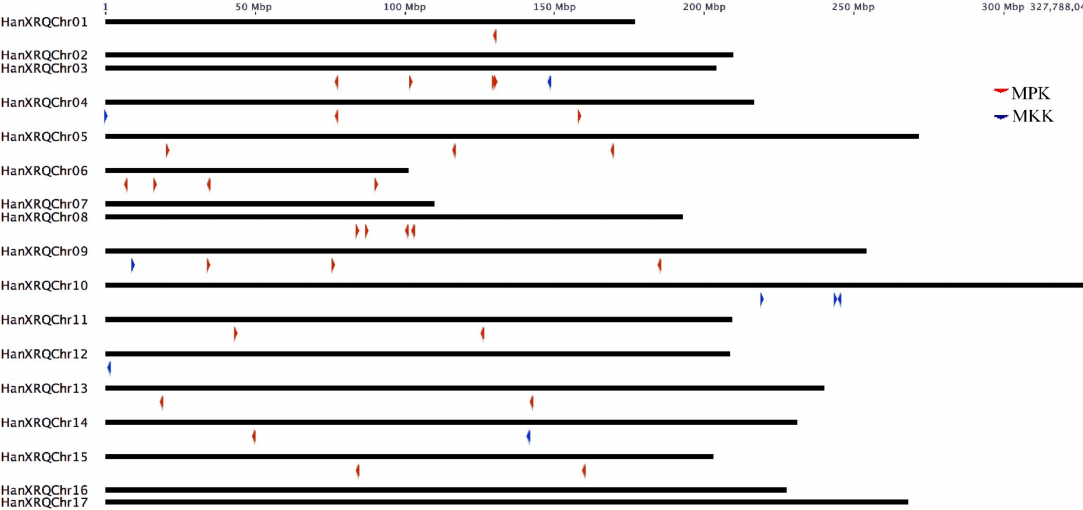
Figure 2. Chromosomal distribution of MPK and MKK genes in sunflower ( n = 17). Color-coded arrows represent MAP Kinase gene types and their orientation on the chromosome indicated by the black